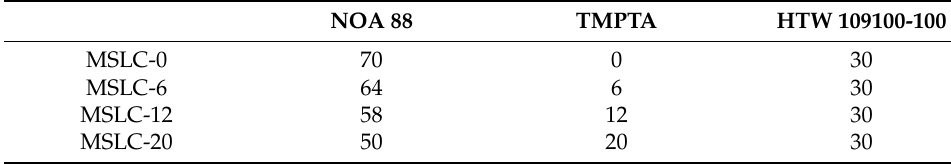
Table 1. Mixing ratios (wt.%) of the four mixtures prepared in this